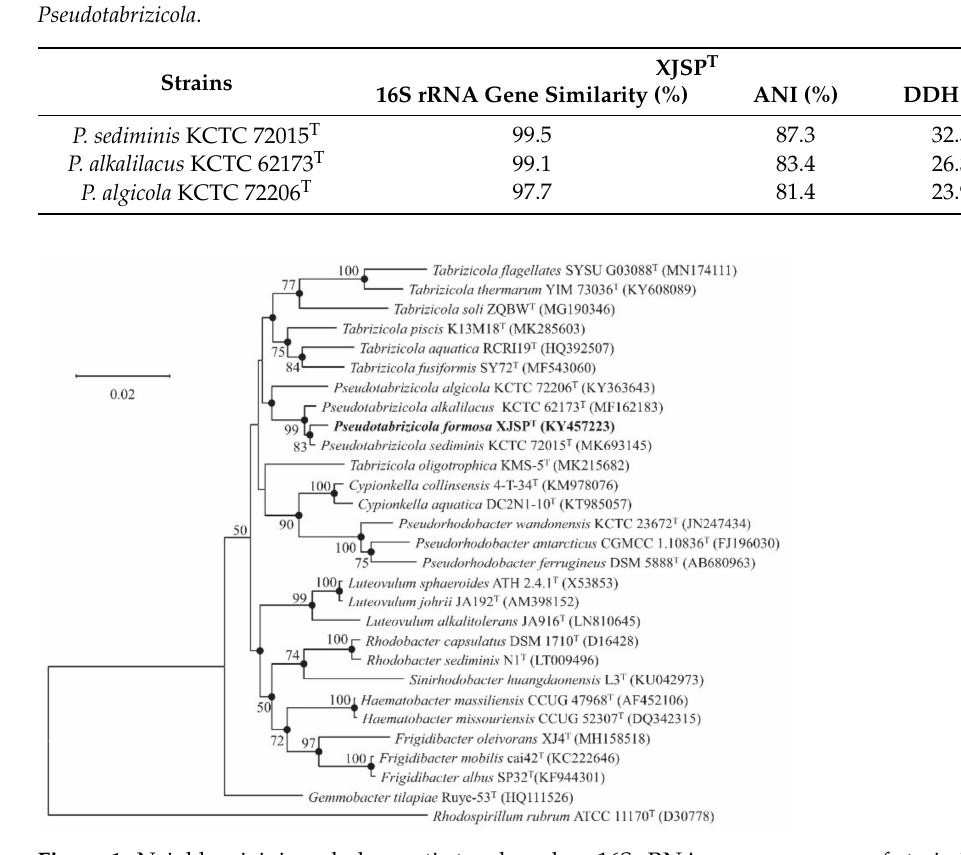
Figure 1. Neighbor-joining phylogenetic tree based on 16S rRNA gene sequences of strain XJSP T and other closely related species. Filled circles indicate branches that were recovered with all three methods (neighbor-joining, maximum-likelihood, and minimum-evolution). Percentages bootstrap values above 50% (1000 replicates) are shown at branch nodes. Rhodospirillum rubrum ATCC 11170 T was used as the out-group. Bar, 0.02 substitutions per nucleotide